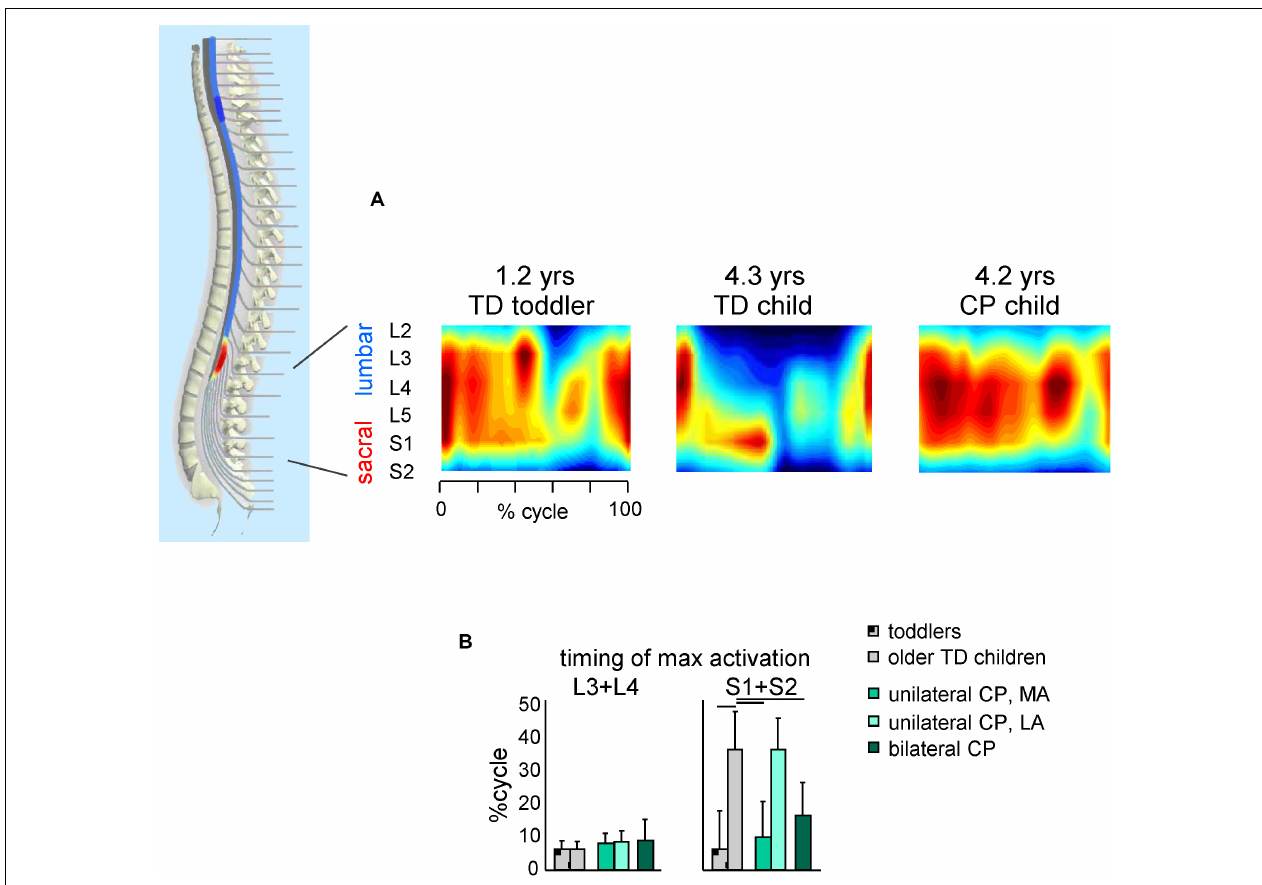
FIGURE 4 | Spatiotemporal maps of motoneuron activity of the lumbosacral enlargement in TD children and children with CP. (A) Examples of segmental output in one TD toddler (1.2 years), one TD older child (4.3 years) and one child with CP (4.2 years) (adapted from Cappellini et al., 2016). (B) Timing (+SD) of maximum activation of lumbar (L3 + L4) and sacral (S1 + S2) segments. Lines over bars denote significant differences compared with older TD